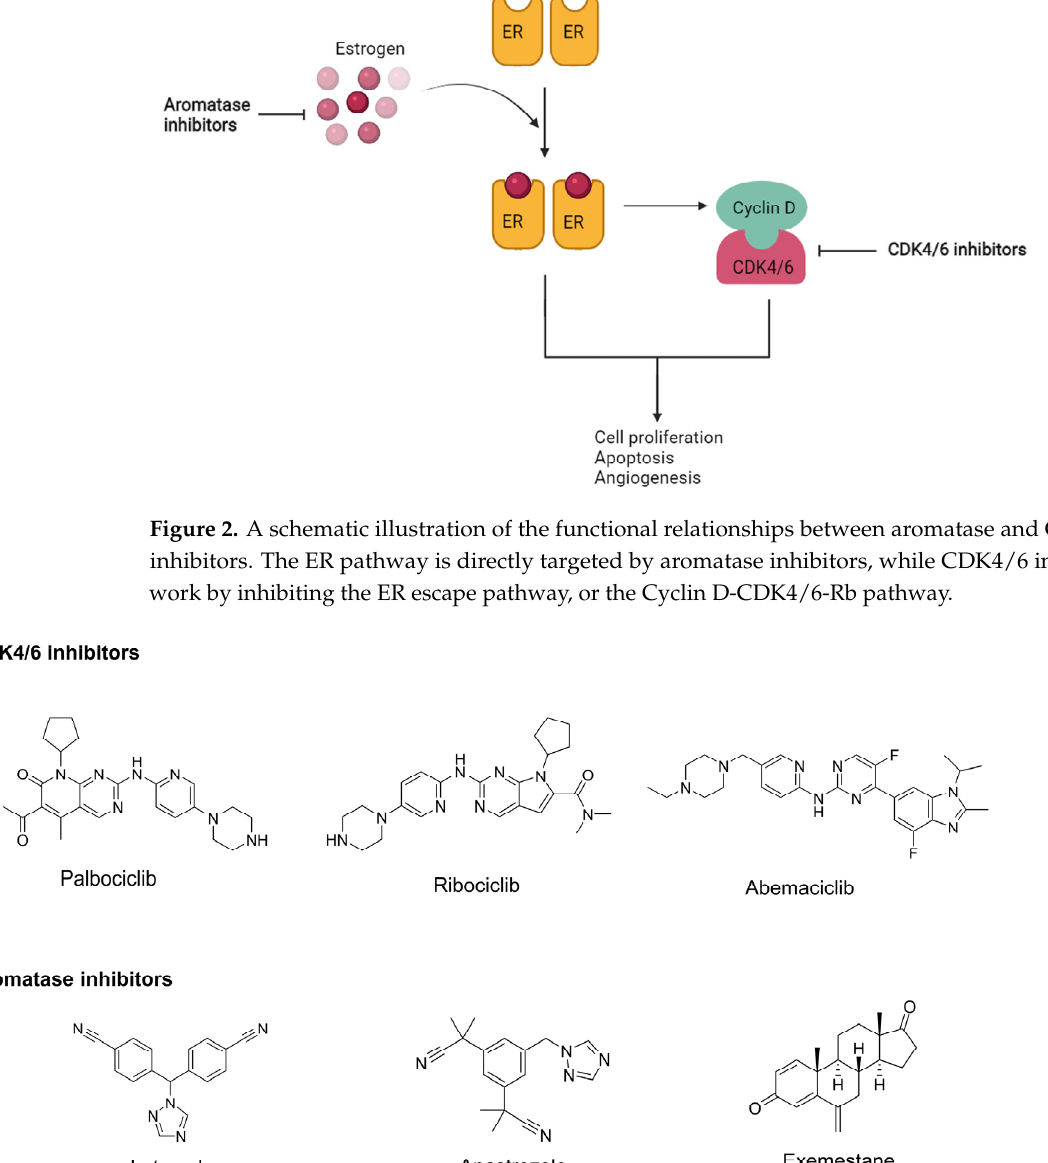
Figure 3. Representative CDK4/6 and aromatase inhibitors have been studied for their potential in combined therapy.